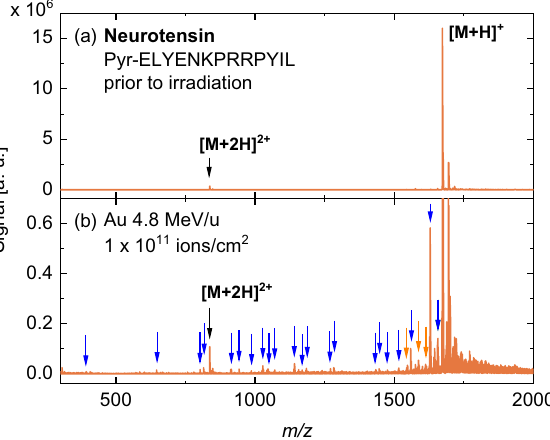
Figure 4. DINeC mass spectra from ( a ) a freshly prepared neurotensin sample and ( b ) the same sample irradiated with 946 MeV Au ions. In the mass spectrum of the irradiated sample, a multitude of fragment peaks is observed. Almost all of these peaks can be assigned to specific fragments of the molecule (Tab. S2). The number of different fragment peaks is significantly higher when compared to spectra of irradiated angiotensin II samples. The peak at m / z = 1694.7 , which is present in both spectra, is assigned to [M+Na] + . The signal intensity close to the peak of the intact molecule ( m / z > 1673 ) is comparable to the measurement before irradiation but appears more pronounced in ( b ) due to the smaller signal